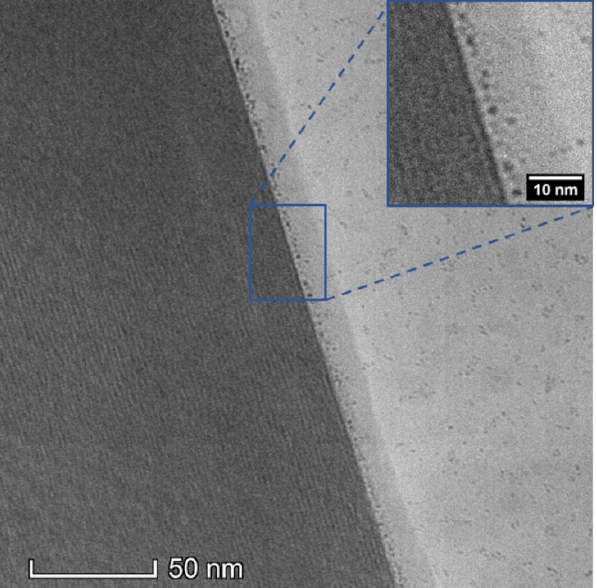
Figure 3. Cryo-TEM micrograph of the solid/liquid interface with the 0.92 CMC Na-AOT solution containing 2.29 mM Na-AOT, 0.032 mM MgCl 2 and 0.025 mM KCl. The sample was tilted so that the mica basal planes were parallel to the illumination for clear imaging of the interface. The inset shows a magnified view of the interface where spherical micelles are visible.